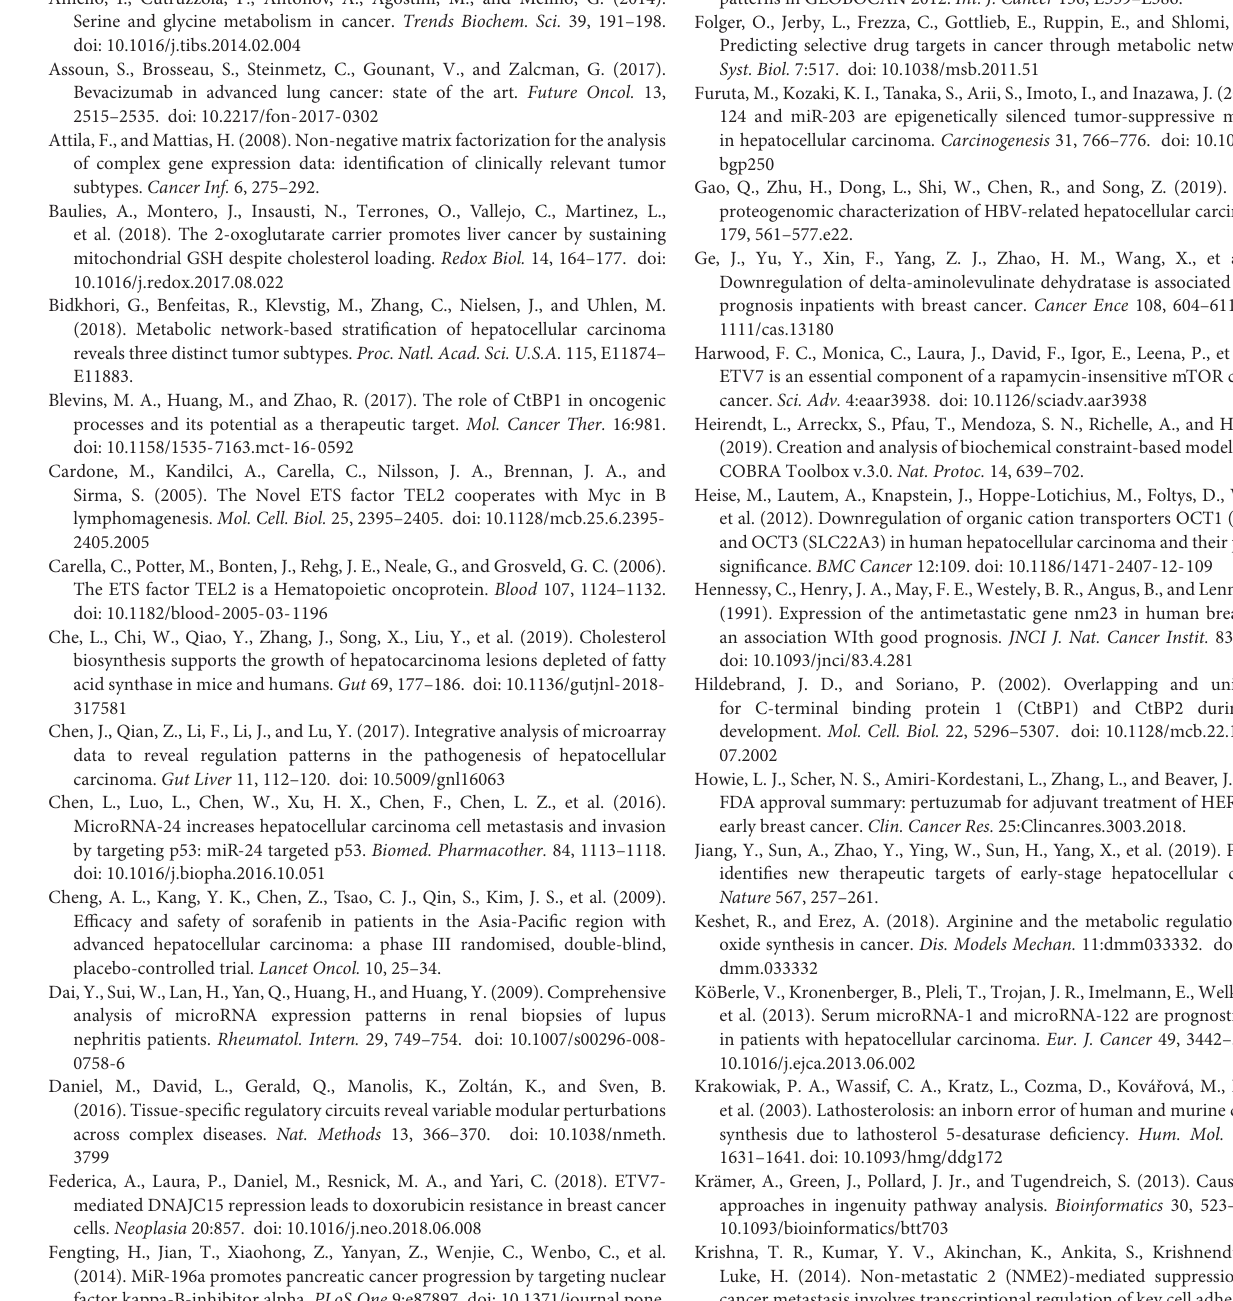
Supplementary Table 1 | Composition of normal/HCC liver model: The regulatory network of normal/HCC liver and the composition of integrated models. Supplementary Table 2 | TFs affecting normal/HCC liver cell growth and corresponding growth ratio after TFs knocking down.